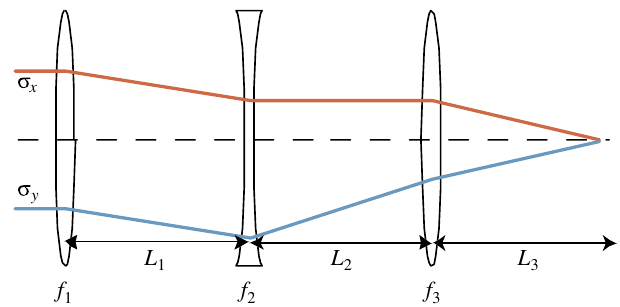
FIG. 7. (Color) Standard triplet design for a symmetric